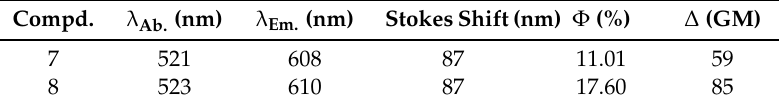
Table 1. Optical properties of the 3-(4-diethylaminocinnamoyl) coumarins in DMSO. Compd. λ Ab. (nm)